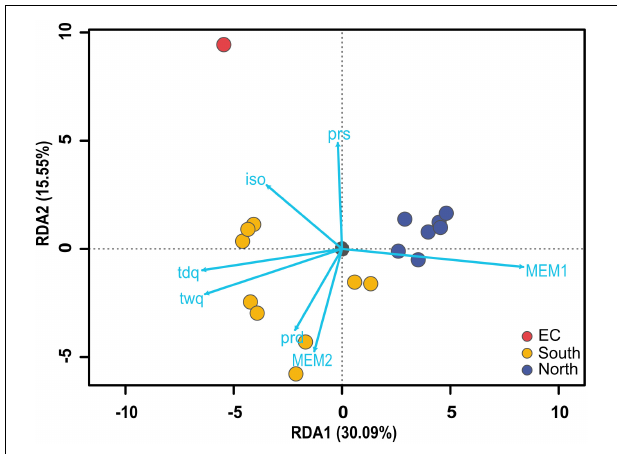
FIGURE 6 | RDA plot demonstrating predictor associations as related to ecotype for the comprehensive SNP data set. iso, Isothermality; tdq, Mean temperature of the driest quarter (Feb, Mar, Apr), twq, Mean temperature of the warmest quarter (Jun, Jul, Aug), prd, Precipitation of the driest month (Apr), prs, Precipitation